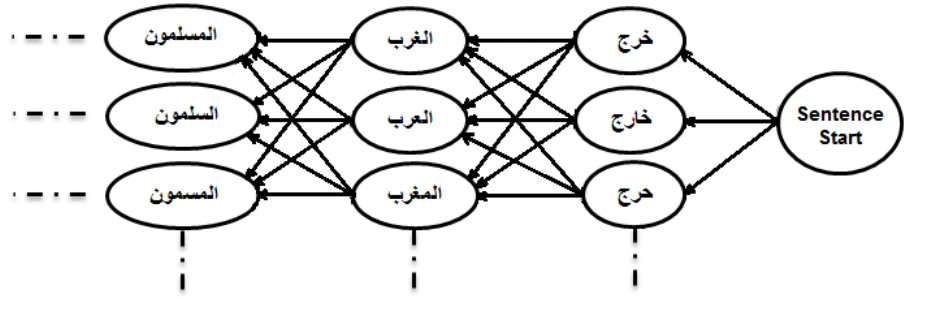
Figure 5. An example of a rescoring lattice.